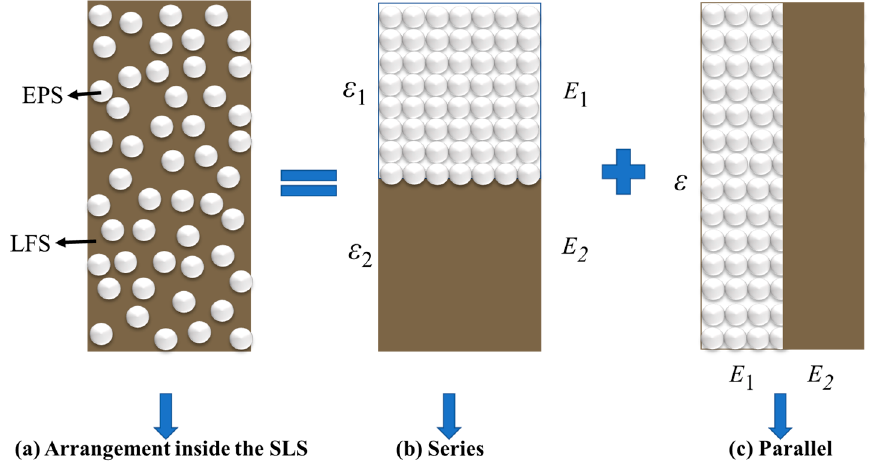
Figure 7. Arrangement of EPS particles and lime fl y ash soil in the sample.